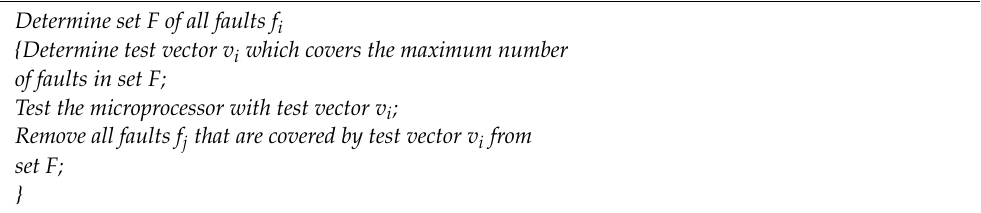
Algorithm 1: Greedy algorithm: the vectors that detect the largest number of faults first. Determine set F of all faults f